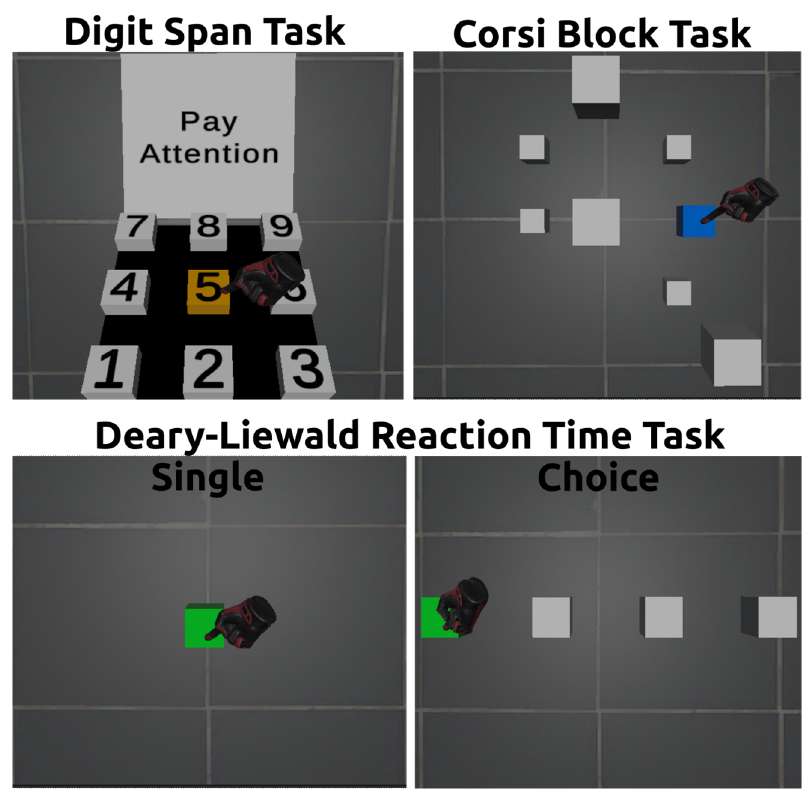
Figure 2. Digit Span Task ( Upper Left ), Corsi Block Task ( Upper Right ), and Deary–Liewald Reaction Time Tasks ( Bottom ).